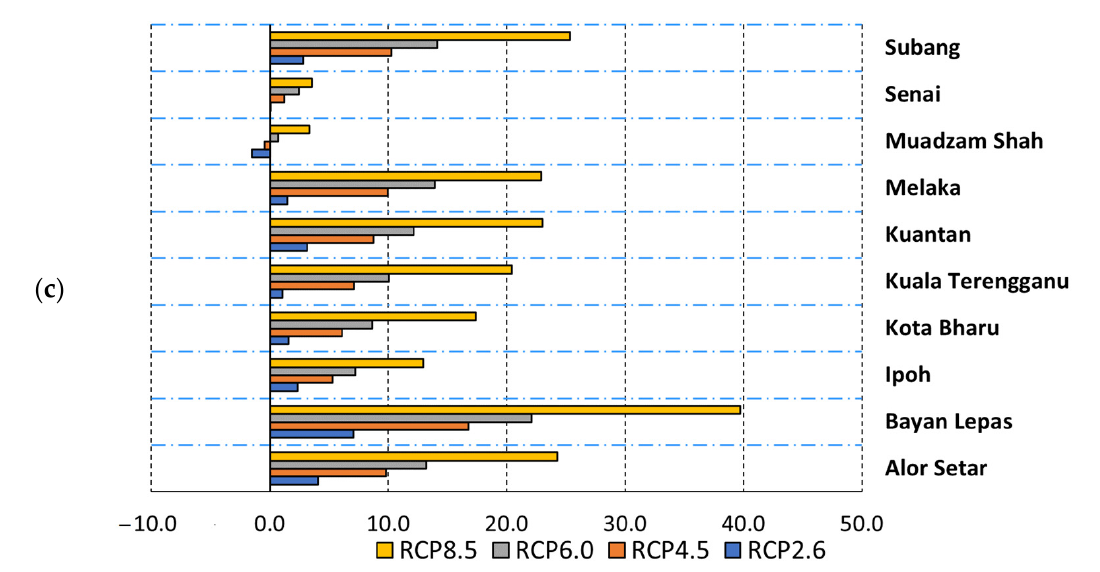
Figure 7. Projected changes (%) in the annual average of daily ET for three future periods: ( a ) 2010–